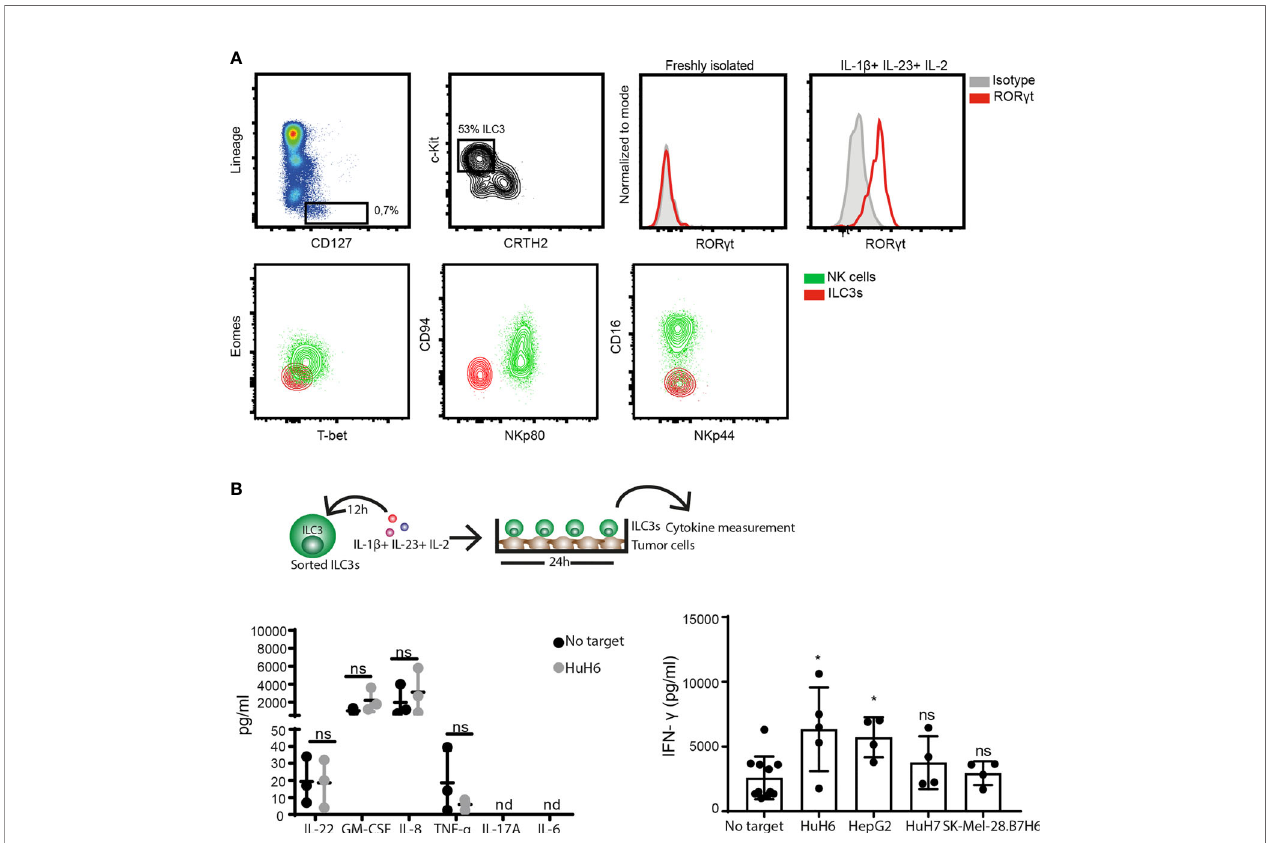
FIGURE 1 | ILC3s increase IFN- g release in response to tumor cells. (A) Representative analysis of blood ILC3s gated as live, CD45 + , Lineage - (CD3 - , CD19 - , CD14 - , CD34 - , CD94 - , CD123 - , TCR a / b - , TCR g / d - , FC ϵ R1 a - ), CD127 + , c-Kit + and CRTH2 - cells (left). Histograms show ROR g t expression by blood-derived freshly-isolated and ILC3s cultured overnight with 100 ng/ml IL-1 b , 100 ng/ml IL-23 and 10 U/ml IL-2 (right). Contour-plots (down) depict expression of Eomes, T-bet, CD94, NKp80, CD16 and NKp44 in gated ILC3s and NK cells (Lin - CD127 - CD56 + NKp80 + ) from peripheral blood. ( B , left) Cytokine-treated ILC3s were washed and co-cultured 24h with HuH6 cells in the presence of 10 U/ml IL-2. Concentrations of IL-22, GM-CSF, IL-8, TNF- a were determined in supernatants (n=3 blood donors), ns, not signi fi cant, by two-way Anova. ( B , right) Concentration of IFN- g was measured in the supernatant of blood ILC3s co-cultured with HuH6, HepG2, HuH7 or SK-Mel-28.B7H6 cells (n=4-5 blood donors), *p <0.05; ns, not signi fi cant, by one-way